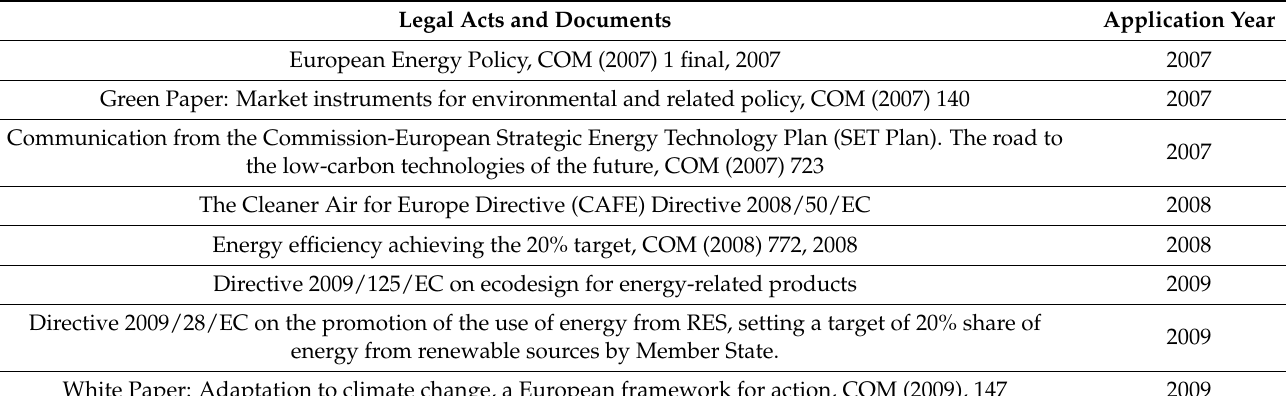
Table 1. The most important EU legal acts and documents concerning the main directions in the energy and climate policy for the years 2007–2019